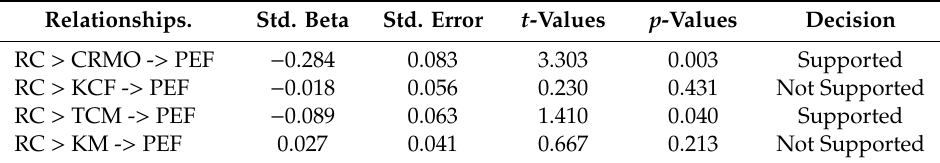
Table 6. The structural model (moderating e ff